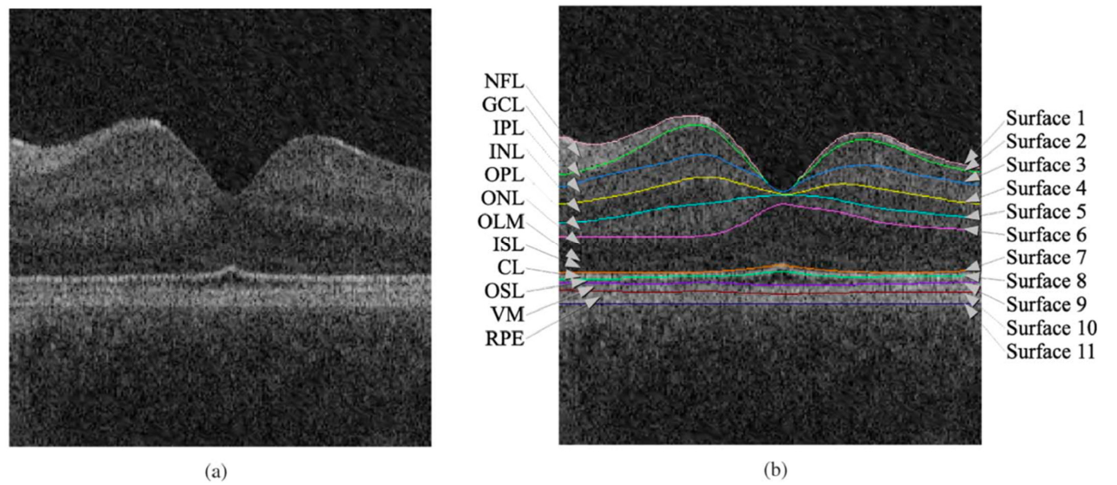
Figure 3. Segmentation result of 11 retinal surfaces (10 layers) of an OCT image: ( a ) OCT image. ( b ) layer segmentation results, nerve fiber layer (NFL), ganglion cell layer (GCL), inner plexiform layer (IPL), inner nuclear layer (INL), outer plexiform layer (OPL), outer nuclear layer (ONL), outer limiting membrane (OLM), inner segment layer (ISL), connecting cilia (CL), outer segment layer (OSL), Verhoeff’s membrane (VM), and retinal pigment epithelium (RPE). The figure was reprinted with permission from Ref. [27]. 2010,